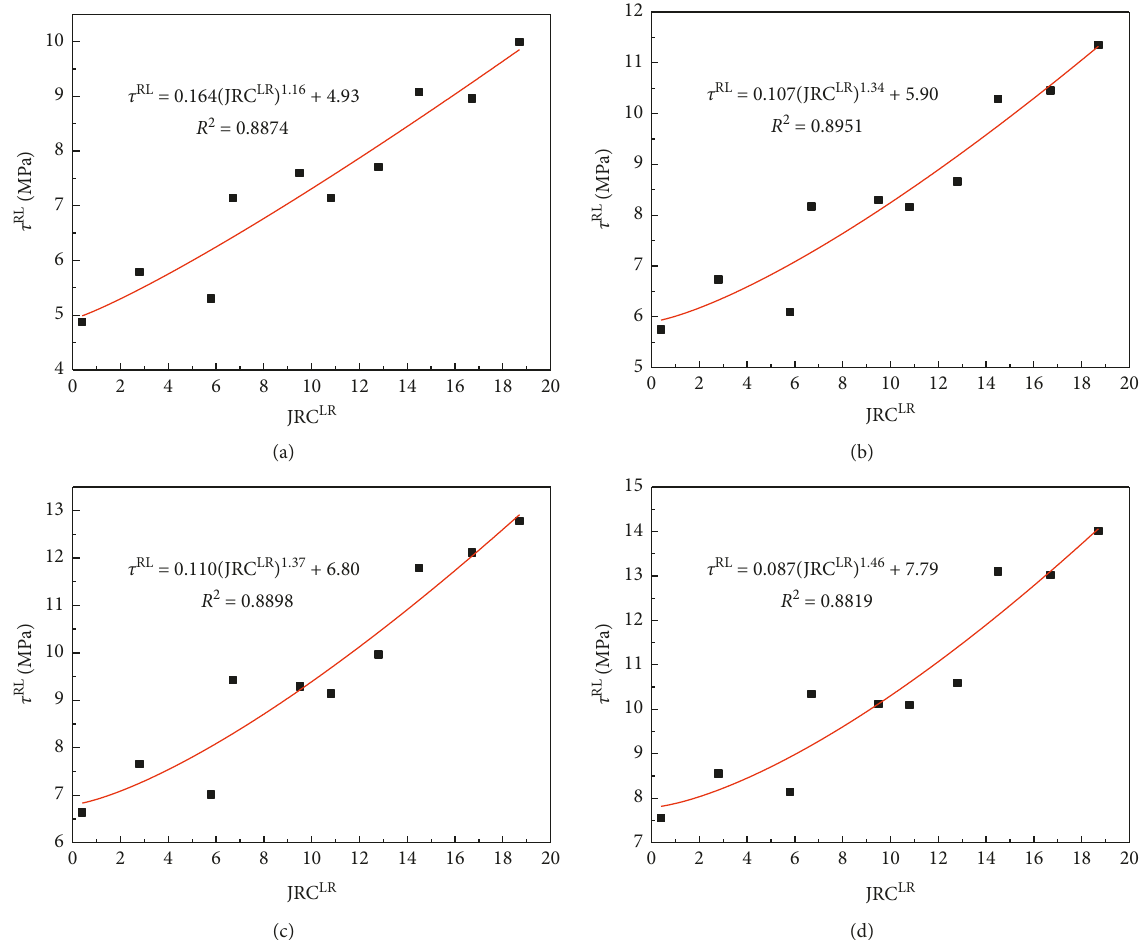
Figure 15: The fitting relationships between JRC LR and τ RL . (a) σ